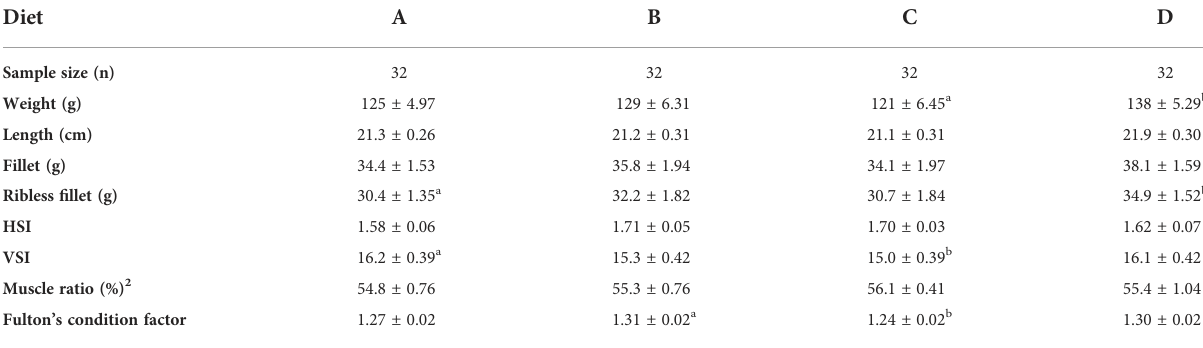
1 Error represented by the mean ± standard error mean. 2 Ratio of total fi llet yield (both sides of the fi sh) to total fi sh weight. ab Different superscript letters represent P<0.05 within a horizontal row after multiple pairwise comparisons using the